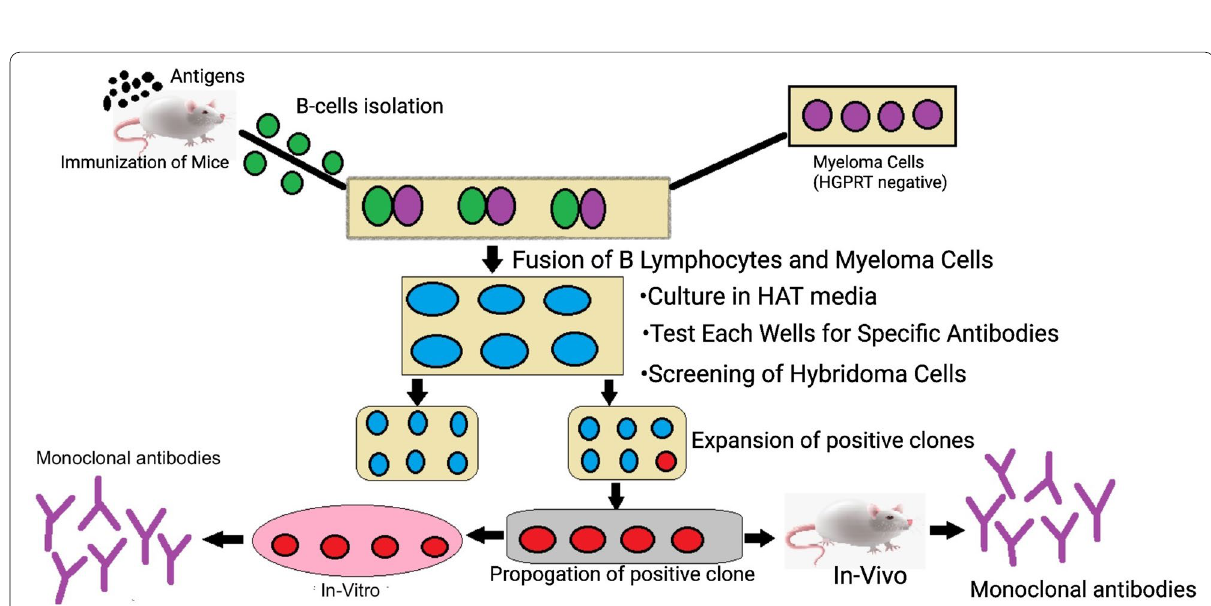
Fig. 4 Diagram showing the production of monoclonal